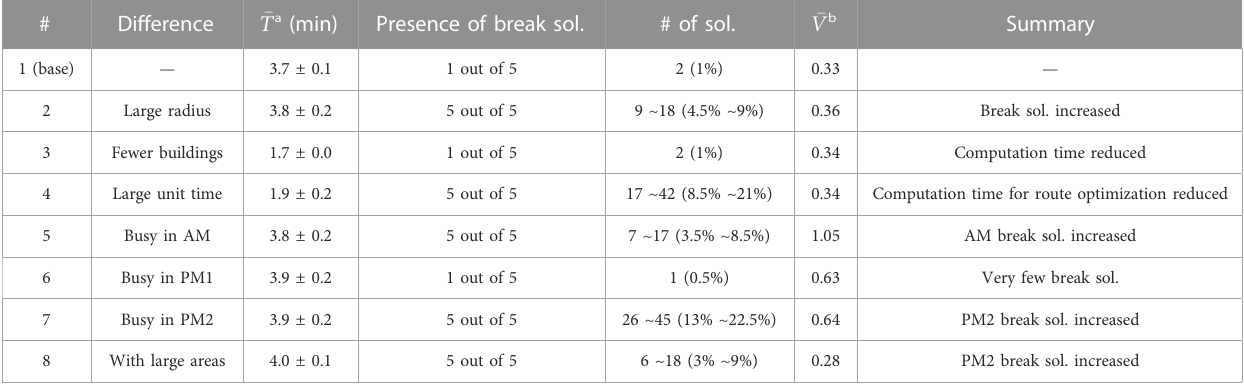
TABLE 9 Summary of numerical experimental results in each